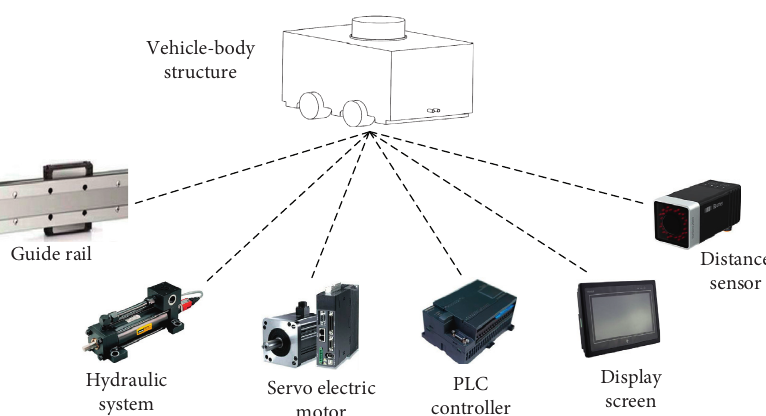
Figure 2: The conceptual scheme of the transfer device.